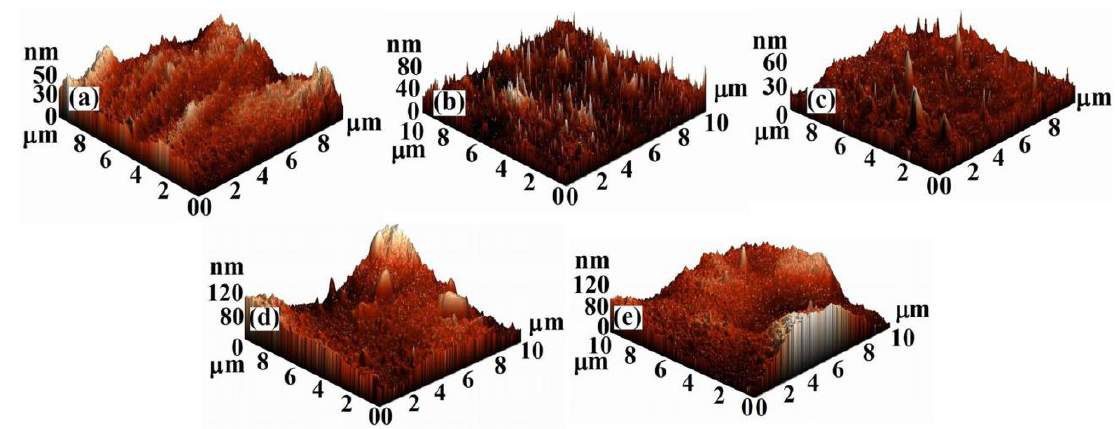
2 10 10μm scan area for: ( a ) CA, ( b ) CA+0.5 wt.% TEOS, ( c ) CA+1.0 wt.% TEOS,